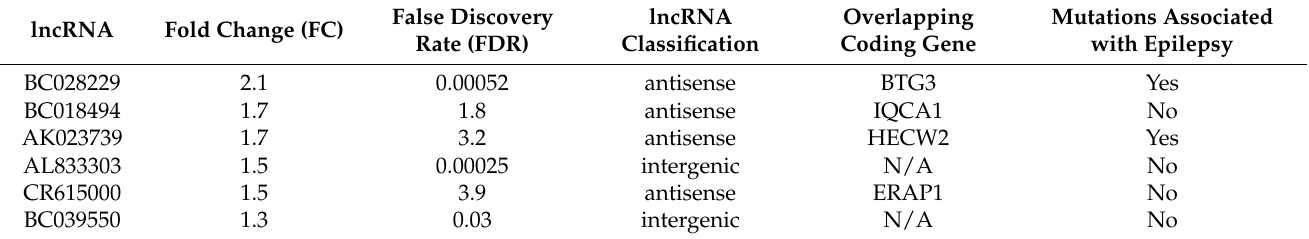
Table 1. Upregulated lncRNA genes identified as co-expressed with MAPK signaling genes. Follow- ing detailed annotation, six upregulated lncRNA were chosen as candidates for further analysis. False Discovery lncRNA